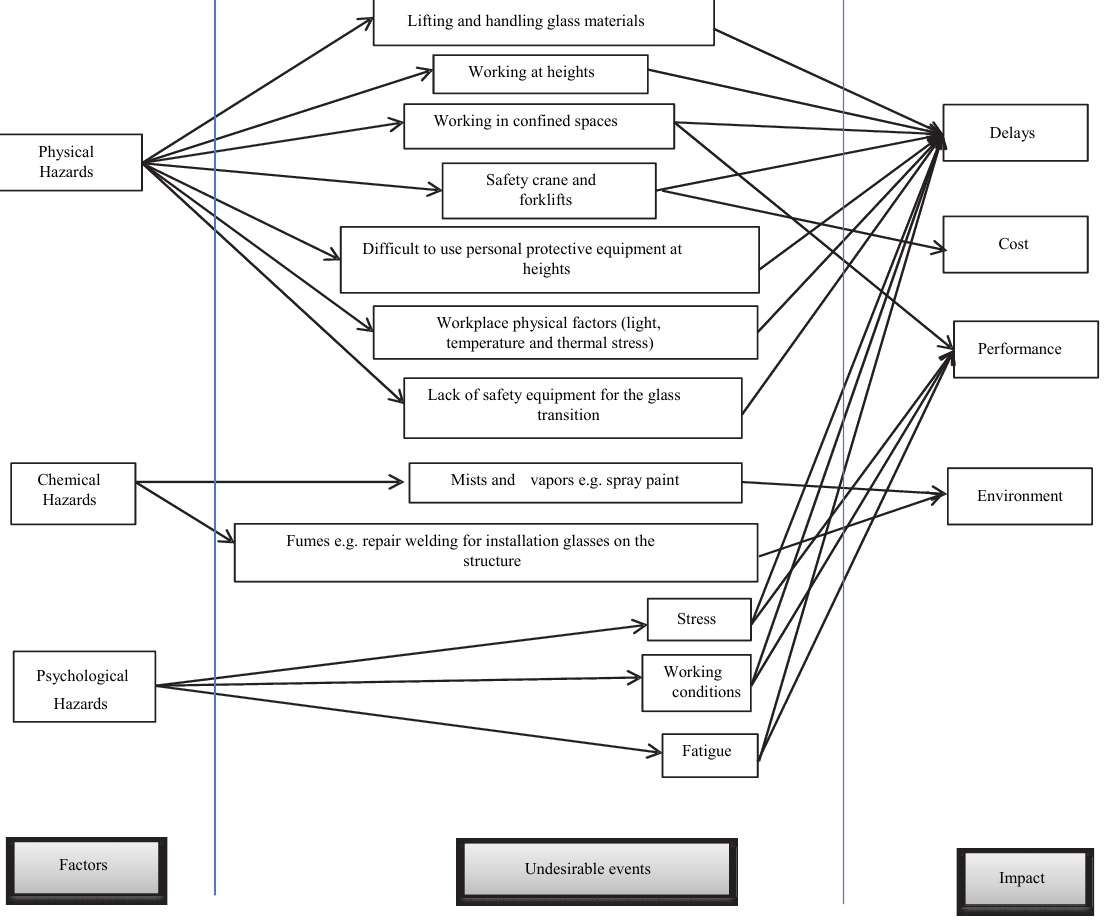
Fig. 4. Case study: links between undesirable events, their risk factors and their